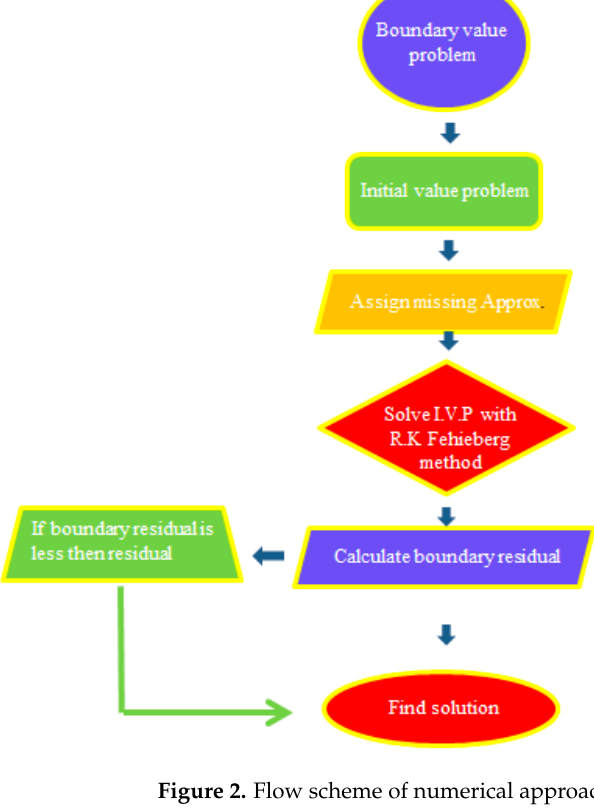
Table 3. The computed results for local skin friction.